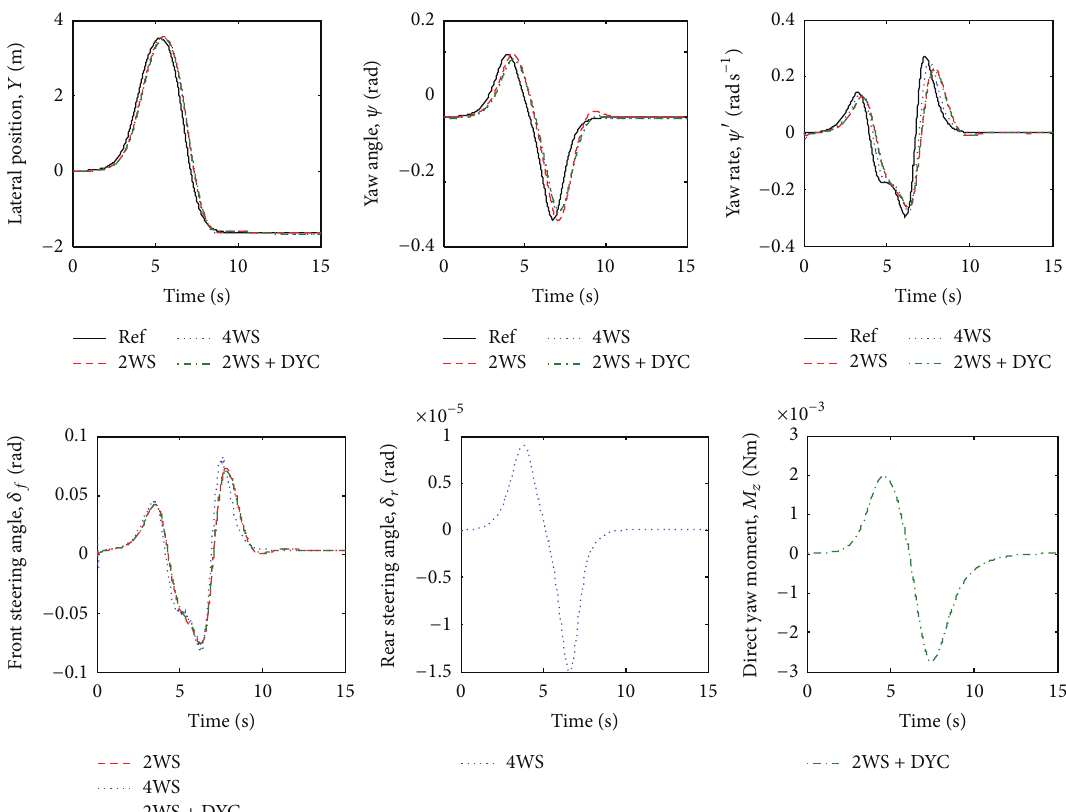
Figure 9: 2DoF controller at 10 ms −1 and 𝜇 = 0.7 by 2WS, 4WS, and 2WS +